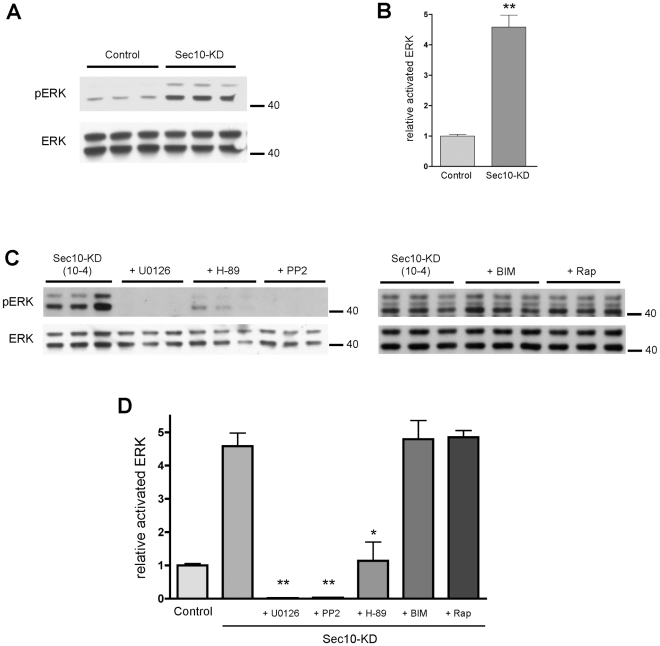
Sec10 knockdown in MDCK cells leads to activation of MAPK.(A) Increased active, or phosphorylated, ERK (pERK) levels are seen by
Western blot following Sec10 knockdown (Sec10-KD) in MDCK cells. (B)
Quantification of results in (A) (** p<0.001). (C) Increased
pERK in Sec10-KD cells is completely blocked by addition of the MEK
inhibitor U0126 and the src inhibitor PP2, while the cAMP-activated PKA
inhibitor H-89 reduces pERK levels to approximately normal levels. Other
kinase inhibitors, including the PKC inhibitor bisindolylmaleimide I
(BIM), and the mTOR inhibitor Rapamycin (RAP), showed no effect on pERK
levels in these cells. (D) Quantification of results in (C) (*
p<0.01, ** p<0.001). Experiments were run in triplicate,
and equal amounts of protein, as determined by BCA, were loaded in each
lane. Antibodies against pERK and total ERK (ERK) were used. The
densities of the pERK bands were normalized to the densities of the
corresponding total ERK bands, and the ratio of pERK:ERK was normalized
to control MDCK cells.